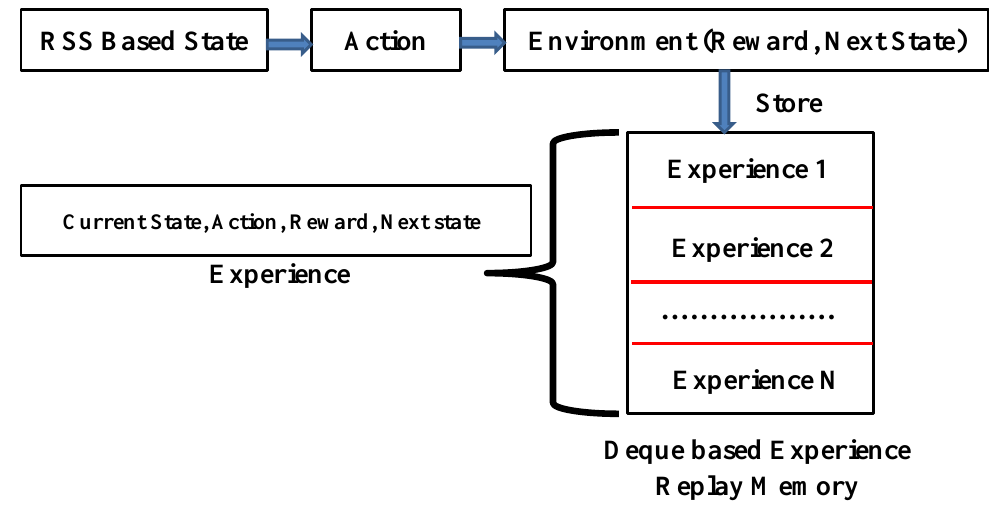
Figure 4. Deque-based experience replay